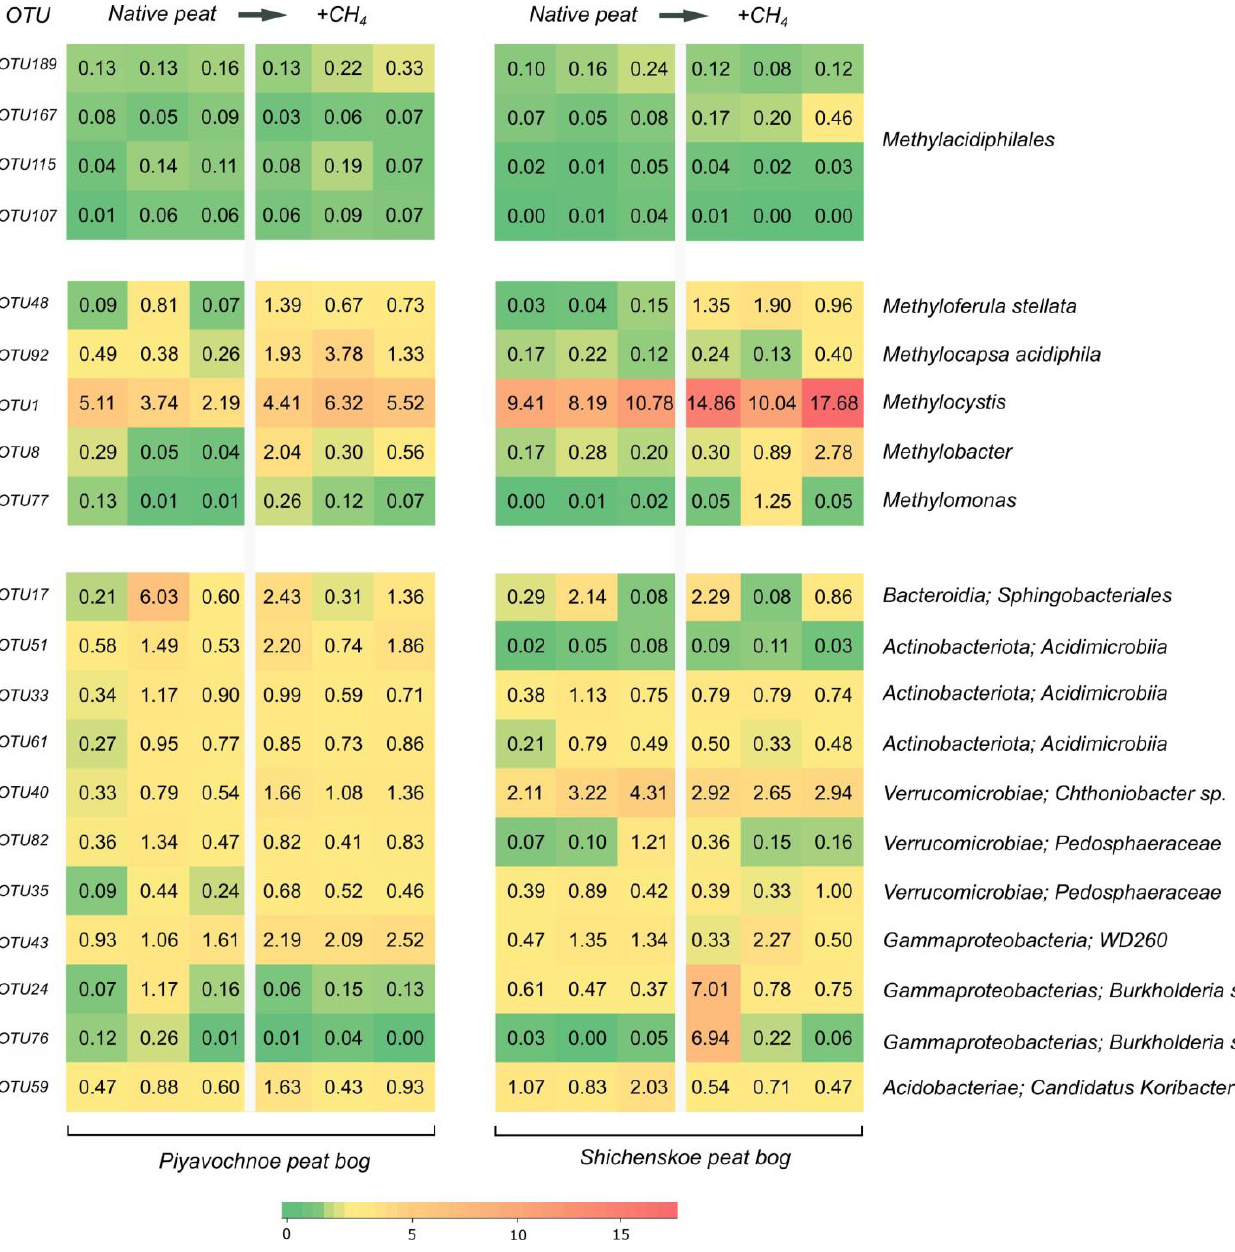
Figure 3. Heatmap showing the relative abundances of well-represented individual OTUs of Methylacidiphilales -affiliated bacteria, proteobacterial methanotrophs and heterotrophic bacteria in peat samples from Piyavochnoe and Shichengskoe raised bogs before and after incubation with 10% CH 4 for 3 weeks. Graphs show three replicate data sets obtained for each group of samples. Table 2. Main characteristics of Methylacidiphilales -affiliated MAGs obtained in this work. MAG